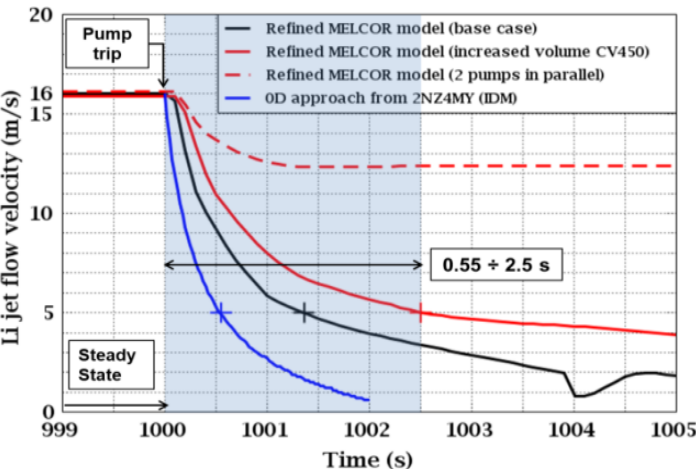
Figure 5. Comparison of Li flow velocities in the target with MELCOR and an analytical prediction Solid blue: simple analytical equations or 0D approach; solid black: base case computed with a circuit MELCOR model and pump trip from 100% to 0% hydraulic power; solid red: same as previous but with an additional reservoir volume at the top of the circuit; dashed red: same as the base case but with a pump trip from 100% to 50% hydraulic power.